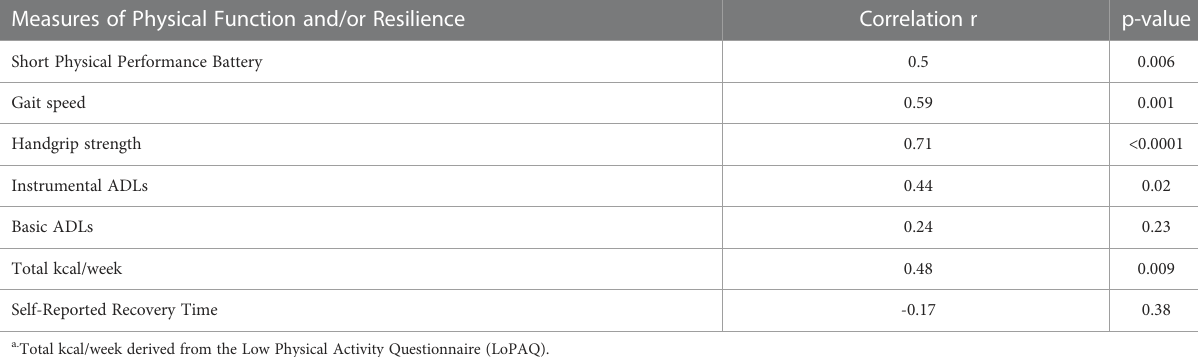
TABLE 2 Pearson Correlations between Step Count Variability and Measures of Physical Function and/or Resilience a . Measures of Physical Function and/or Resilience